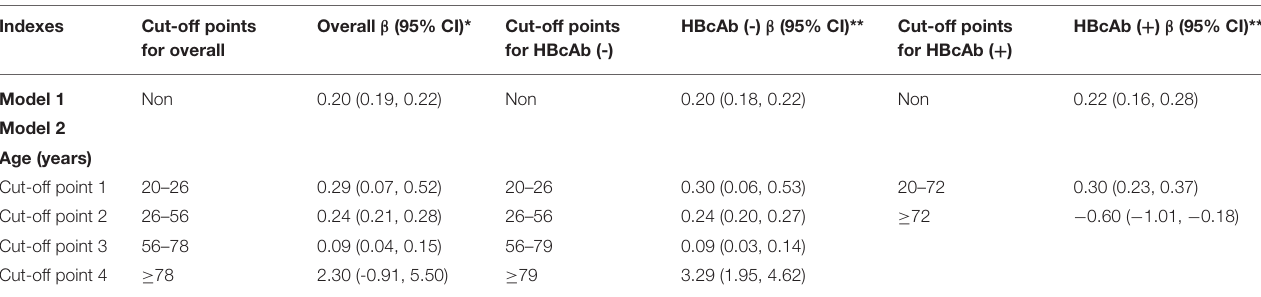
TABLE 3 | Cut-off points and segmentation effects for age